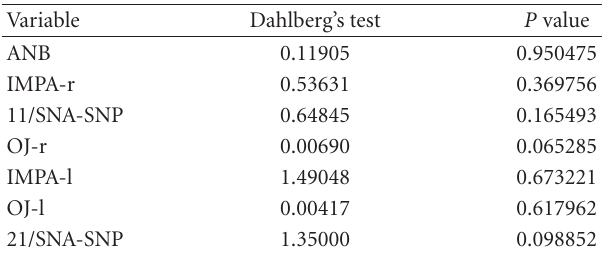
(cid:2) d 2 / 2 n applied to the entire sample Table 1: Dahlberg’s d test: s 2 = and repeated twice revealed no statistically significant systematic measurement errors. The systematic error calculated via Student’s t -test for paired data yielded a significance level of